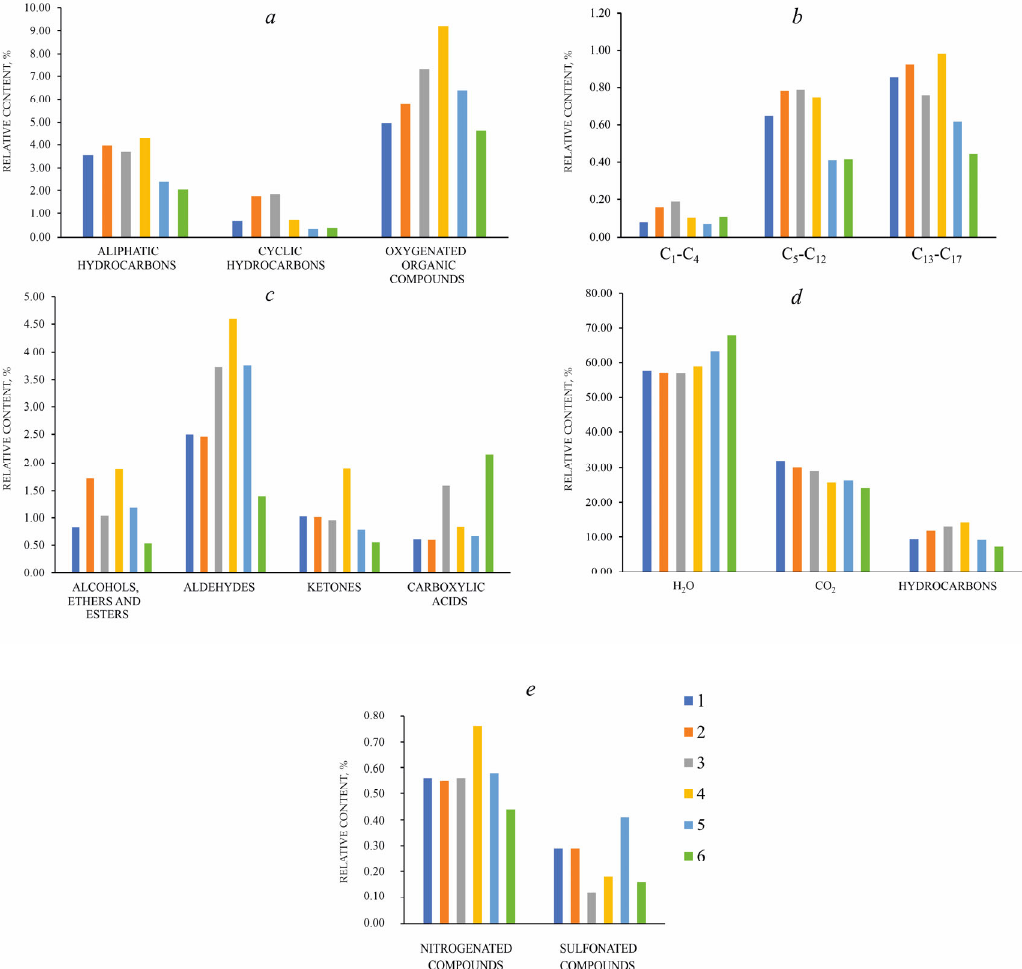
Figure 7. Content of hydrocarbons, carbon dioxide, and water in cordierites from the Muzkol metamorphic complex of Tajikistan based on 6 samples: ( a ) relative content of aliphatic, cyclic, and oxygenated hydrocarbons; ( b ) relative content of “light” (C 1 –C 4 ), “medium” (C 5 –C 12 ) and “heavy” (C 13 –C 17 ) hydrocarbons; ( c ) relative content of alcohols, ethers and esters, aldehydes, ketones, and carboxylic acids; ( d ) relative content of hydrocarbons, carbon dioxide, water, and ( e ) nitrogen ‐ and sulfur ‐ containing compounds; 1–6—sample numbers.